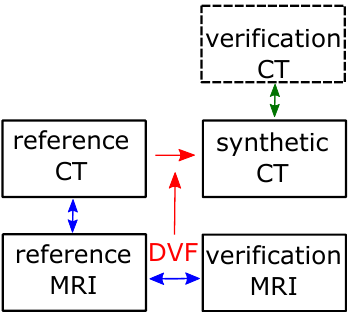
Figure 1. Image processing workflow. Blue arrows indicate the established DIRs. The red arrows indicate the retrieval of the DVF and its use for the generation of the synthetic CT. The green arrows and the block with the dashed frame indicate the validation